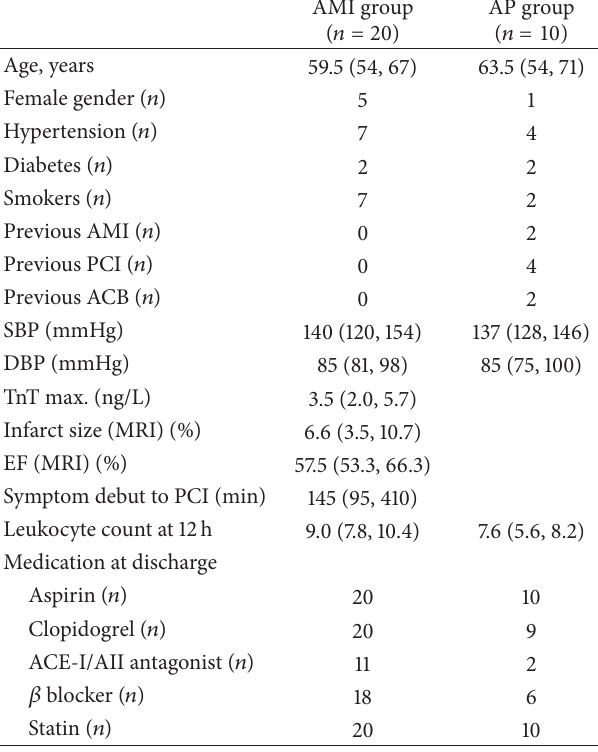
Table 1: Baseline characteristics of the study populations.